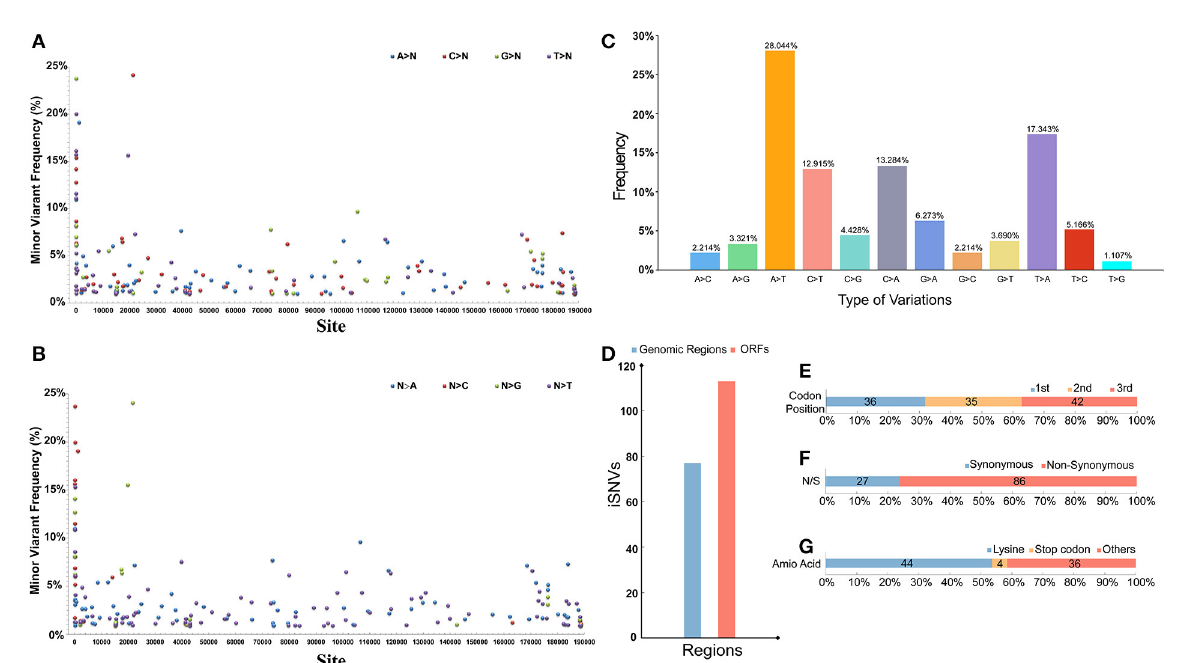
FIGURE5 (A) The distribution and frequency of theiSNVs) that a certain base (A, T, C, G) mutate into other three bases. (B) The distribution and frequency of the iSNVs that the other three bases mutate into a certain base. (C) The percentage of different iSNVs mutation types. (D) Number of iSNVs in coding and non-coding regions. (E) Proportion of iSNVs occurring in different positions in codons across the genome. (F) Proportion of iSNVs causing non-synonymous and synonymous mutations. (G) Proportion of iSNVs that mutate into different type of amino acid. The number of iSNVs in each figure is indicated on the corresponding